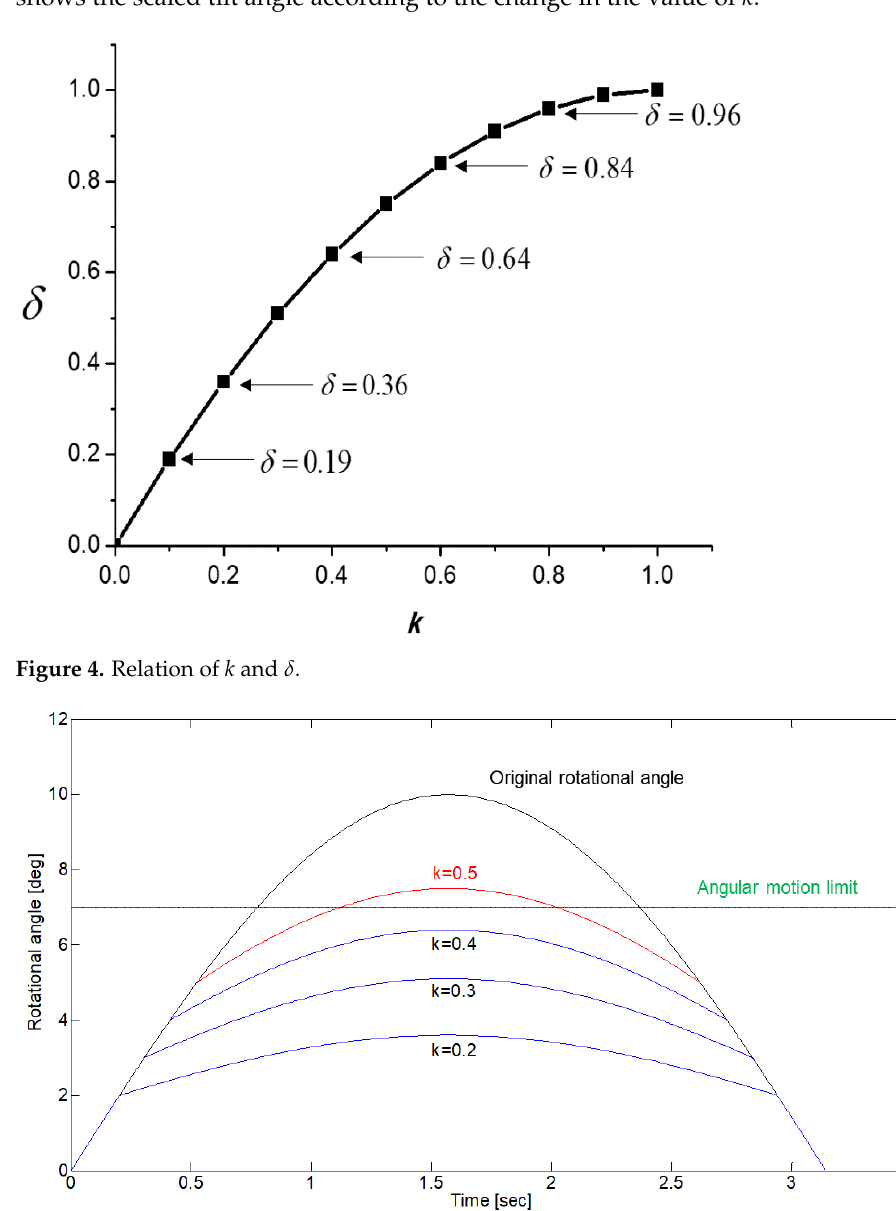
Figure 5. Example of rotational angle according to value of k